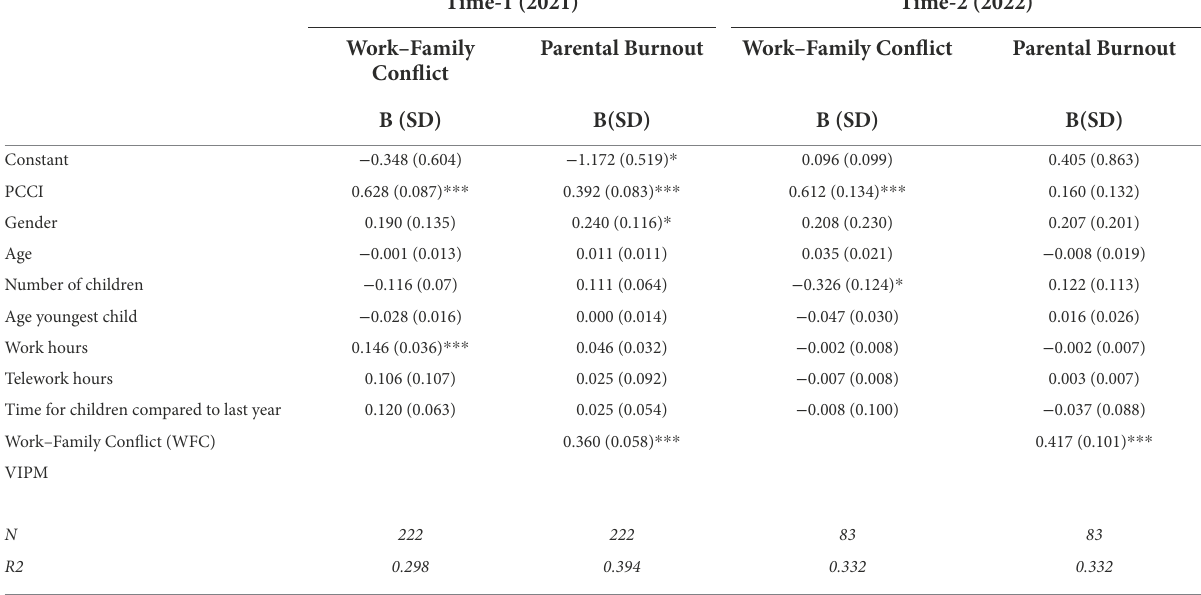
TABLE 3 Hayes mediation analysis on parental burnout (Y) with Work–Family Conflict (M) and PCCI (X; models 1 and